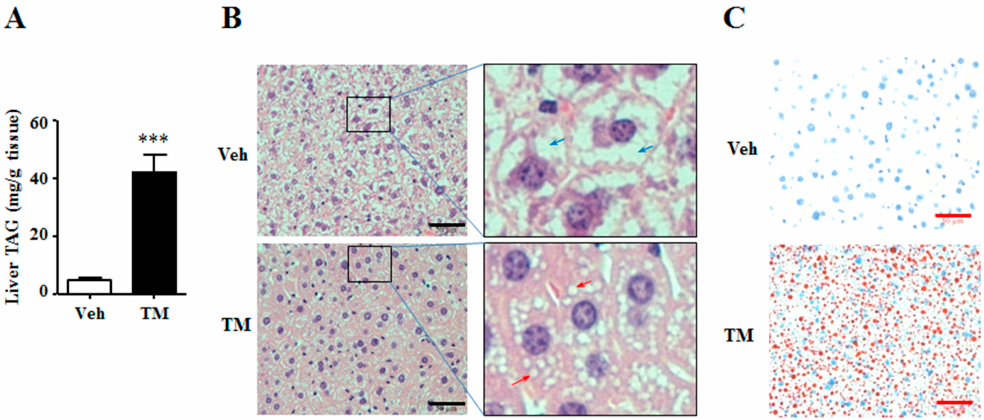
Figure 3. Tunicamycin induced liver triglyceride accumulation. 7-month-old mice were intraperitoneally injected with vehicle or 1 mg/kg tunicamycin. Livers were collected 24 h after injection. N = 6 per group. ( A ) Liver triglyceride content; ( B ) H&E staining of liver. Red arrows indicated lipid droplets, and blue arrows stood for glycogen particles; ( C ) Oil-red O staining of liver. Scale bars were equal to 50 μ m. Data were expressed as mean ± SEM. Veh, vehicle; TM, tunicamycin. *** p < 0.001 TM vs. Veh.